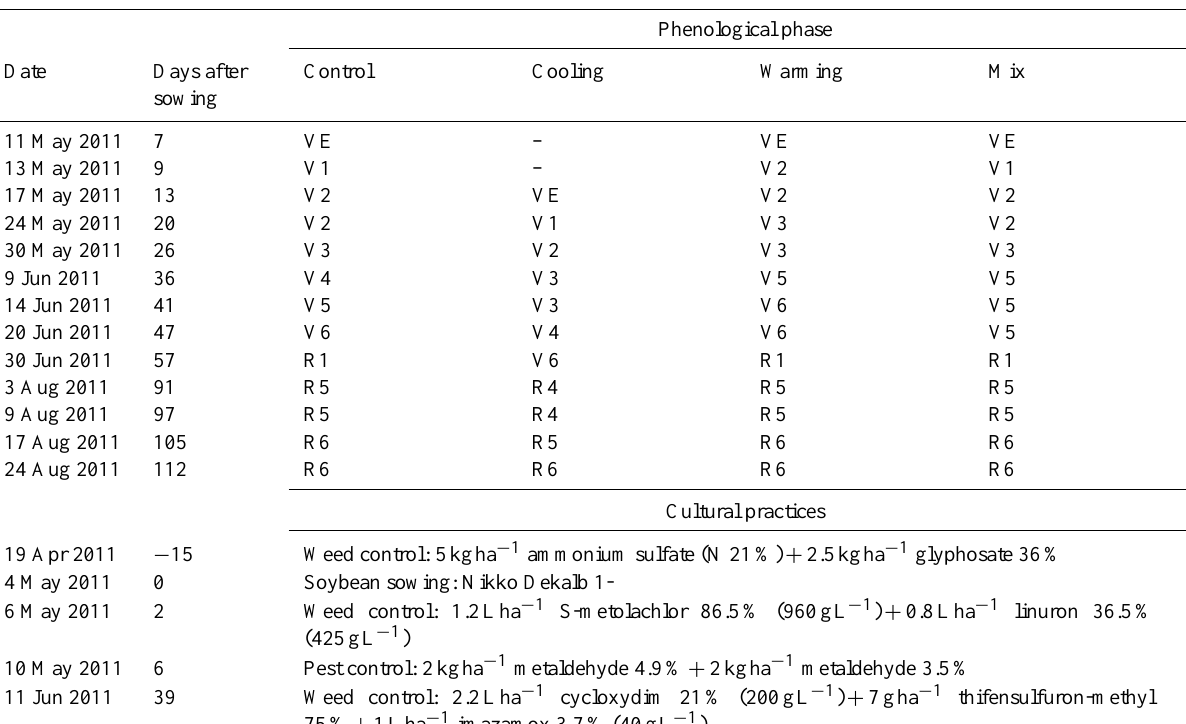
Table 1. Cultural practices and phenological phases according to Fehr–Caviness scale (Fehr et al., 1971). Phenological phase abbrevia- tions: VE = emergence; V1 = first node; V2 = second node; V n = n -th node; R1 = beginning bloom; R2 = full bloom; R3 = beginning pod; R4 = full pod; R5 = beginning seed; R6 = full